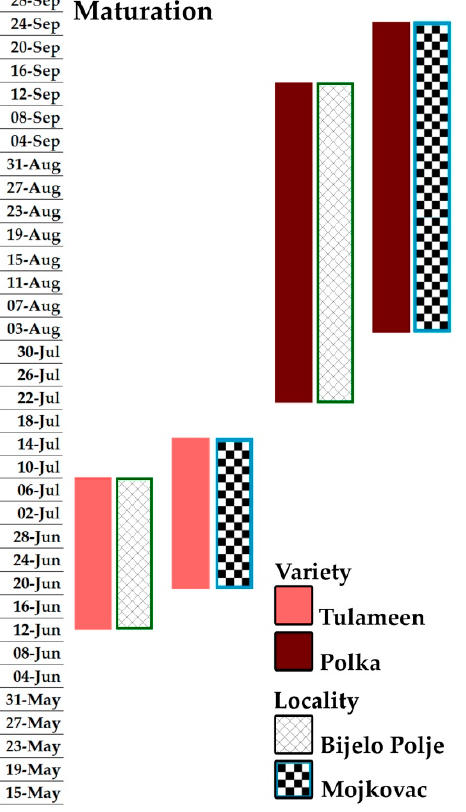
Figure 5. Maturation phenophase of the Polka and Tulameen varieties in the localities Bijelo Polje and Mojkovac—Montenegro (average, years 2018/2019).